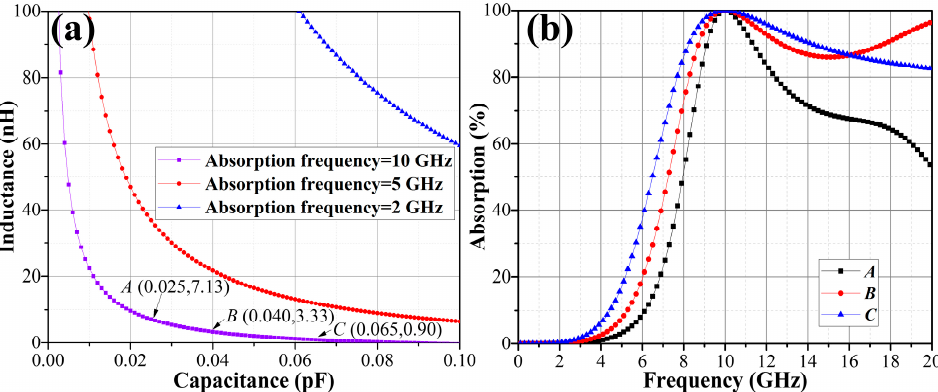
Figure 2. ( a ) the L – C relationship curves at 2 GHz, 5 GHz and 10 GHz: dielectric thickness d = 3 mm and relative permittivity ε r = 2.5; ( b ) the absorption curves of three design examples with the design parameters presented in Table 1. Table 1. The design parameters of three examples in Figure 2b and their absorption performances. The L and C are extracted from the purple curve in Figure 2a. The R is calculated from Equation (6) by replacing ε r , d and f with 2.5, 3 mm and 10 GHz, respectively.